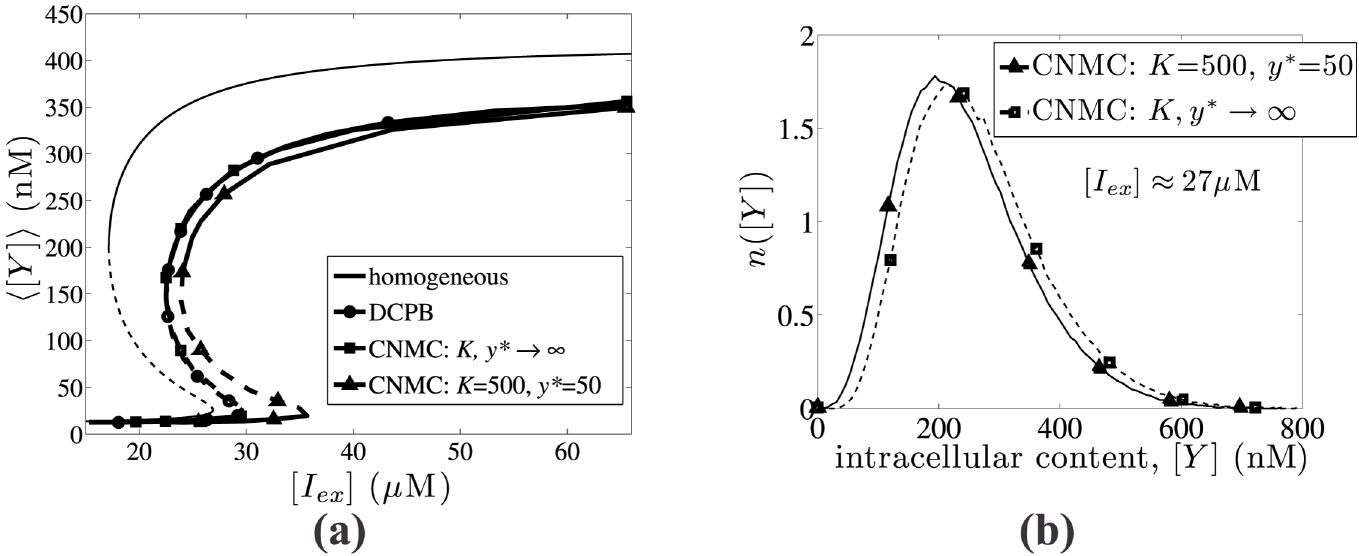
Fig 6. Effect of intrinsic heterogeneity. (a) Steady state average expression level, h [ Y ] i , as a function of the external IPTG concentration, [ I ex ]. The black lines (solid and dashed) correspond to the homogeneous model, the lines with open circles to the DCPB model; the lines with open squares correspond to the CNMC model neglecting the intrinsic source of heterogeneity and the lines with open triangles to the CNMC model incorporating intrinsic noise effects. (b) Steady state solutions of the number density function, n ([ Y ]), corresponding to the upper stable solution branches of CNMC simulations for [ I ex ] (cid:5) 27 μ M, when intrinsic noise is incorporated ( K = 500, y * = 50) and when neglected ( K , y * ! 1